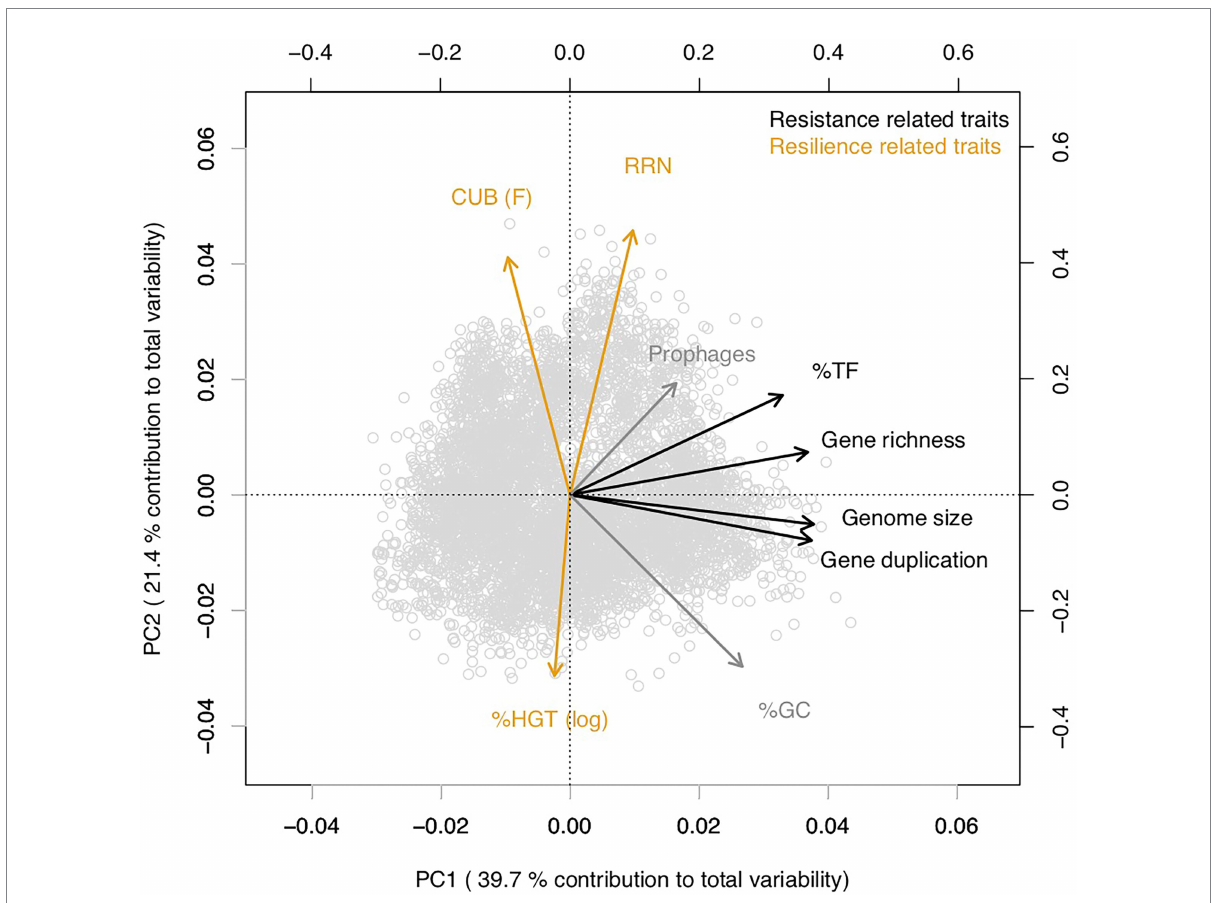
FIGURE 3 Principal component analysis illustrating covariations among genomic traits from 17,856 sequenced prokaryotic genomes available via the JGI/ IMG platform (https://img.jgi.doe.gov/) that were averaged at the species level (Supplementary Table S1). Traits assigned in this study as resistance and resilience traits were colored in black and orange, respectively. %GC and prophages that were not assigned in this study to either resistance or resilience related traits were colored in gray. 5,823 out 8,847 species shared values for all considered traits and were included in the analyzes. The values for %HGT were log(x + 0.001) transformed to approximate a normal distribution. We have chosen to display the CUB parameter F (Vieira- Silva and Rocha, 2010) instead of generation time estimations that can be delineated from the CUB, because F is unambiguously defined for all genomes. In contrast, generation time estimations have been suggested to be inaccurate for genomes with large CUB